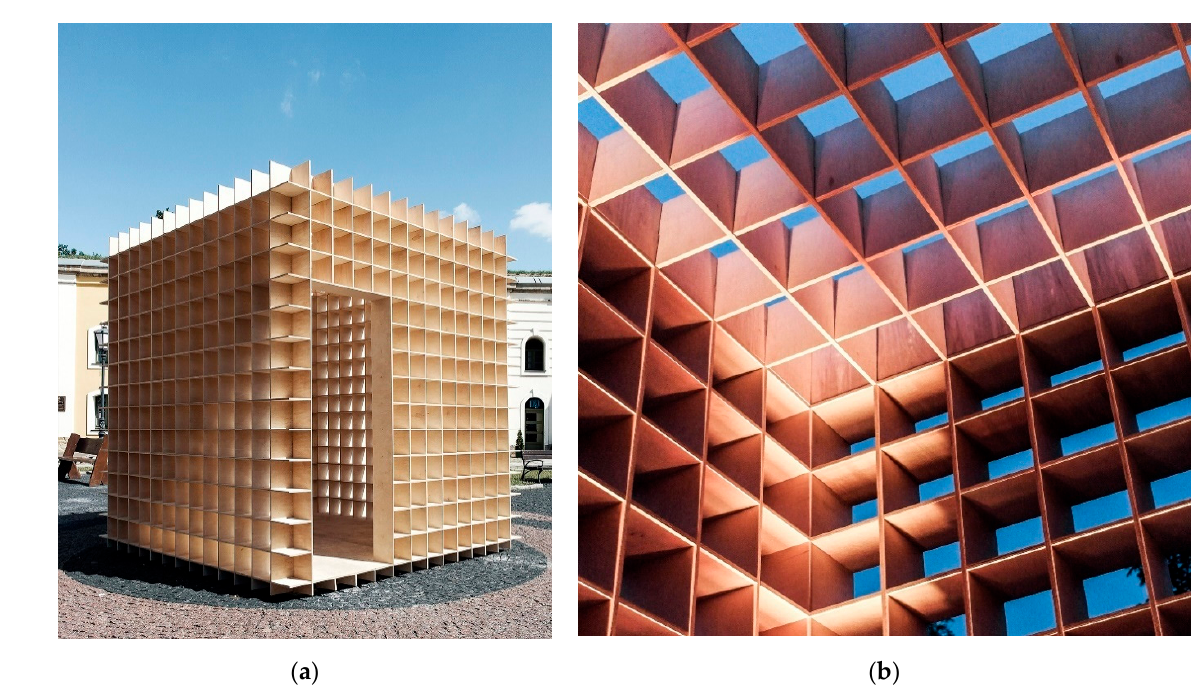
Figure 4. Wood and Shadow Pavilion, 2016: ( a ) general view of the pavilion; ( b ) interior of the Wood and Shadow Pavilion, 2016, reproduced with permission from the Chamber of Polish Architects branch in Opole.